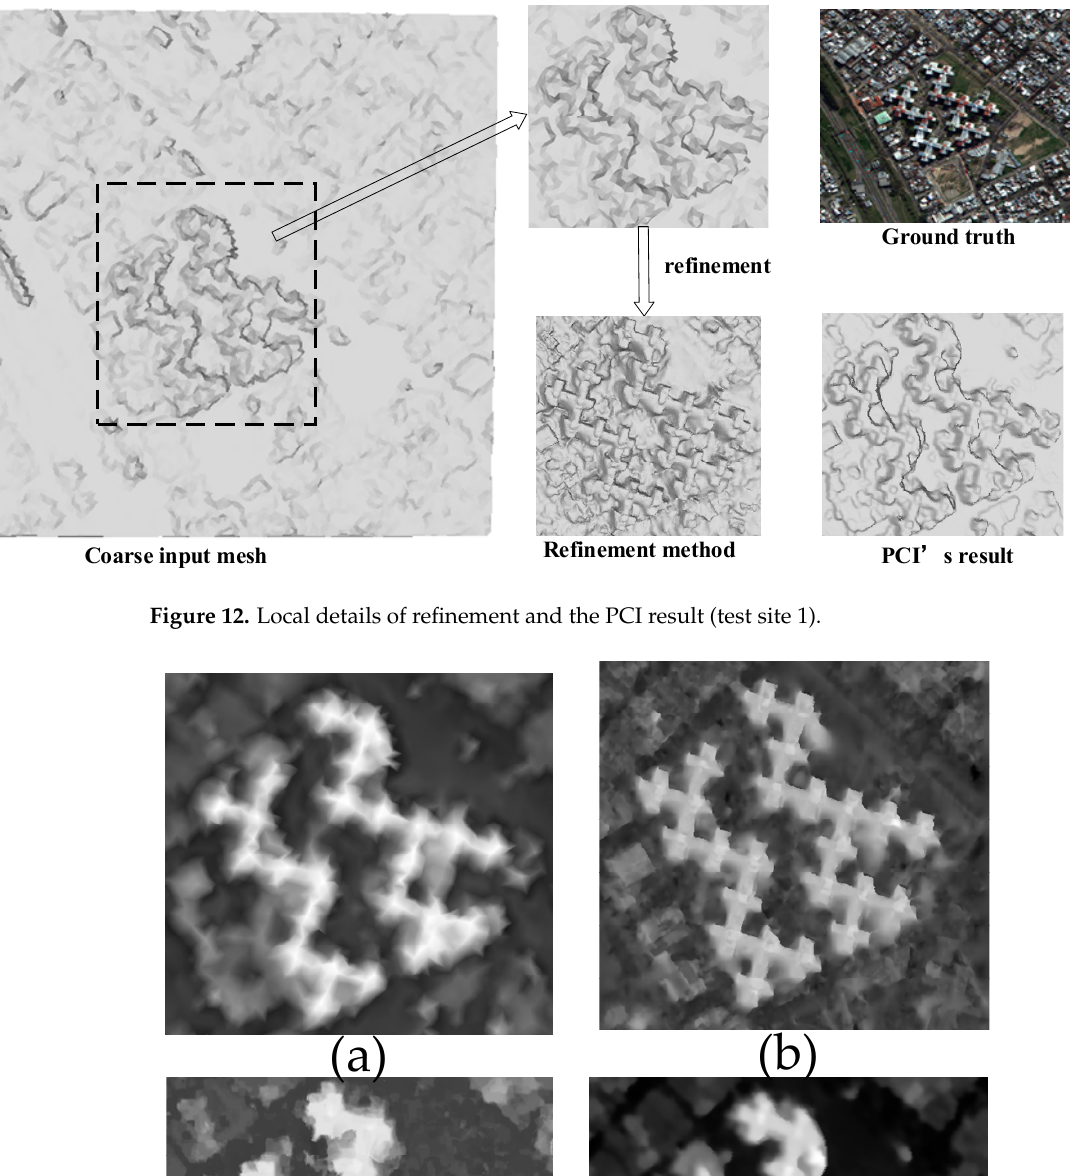
Figure 11. Results of refinement: ( a ) test site 1, ( b ) test site 2.